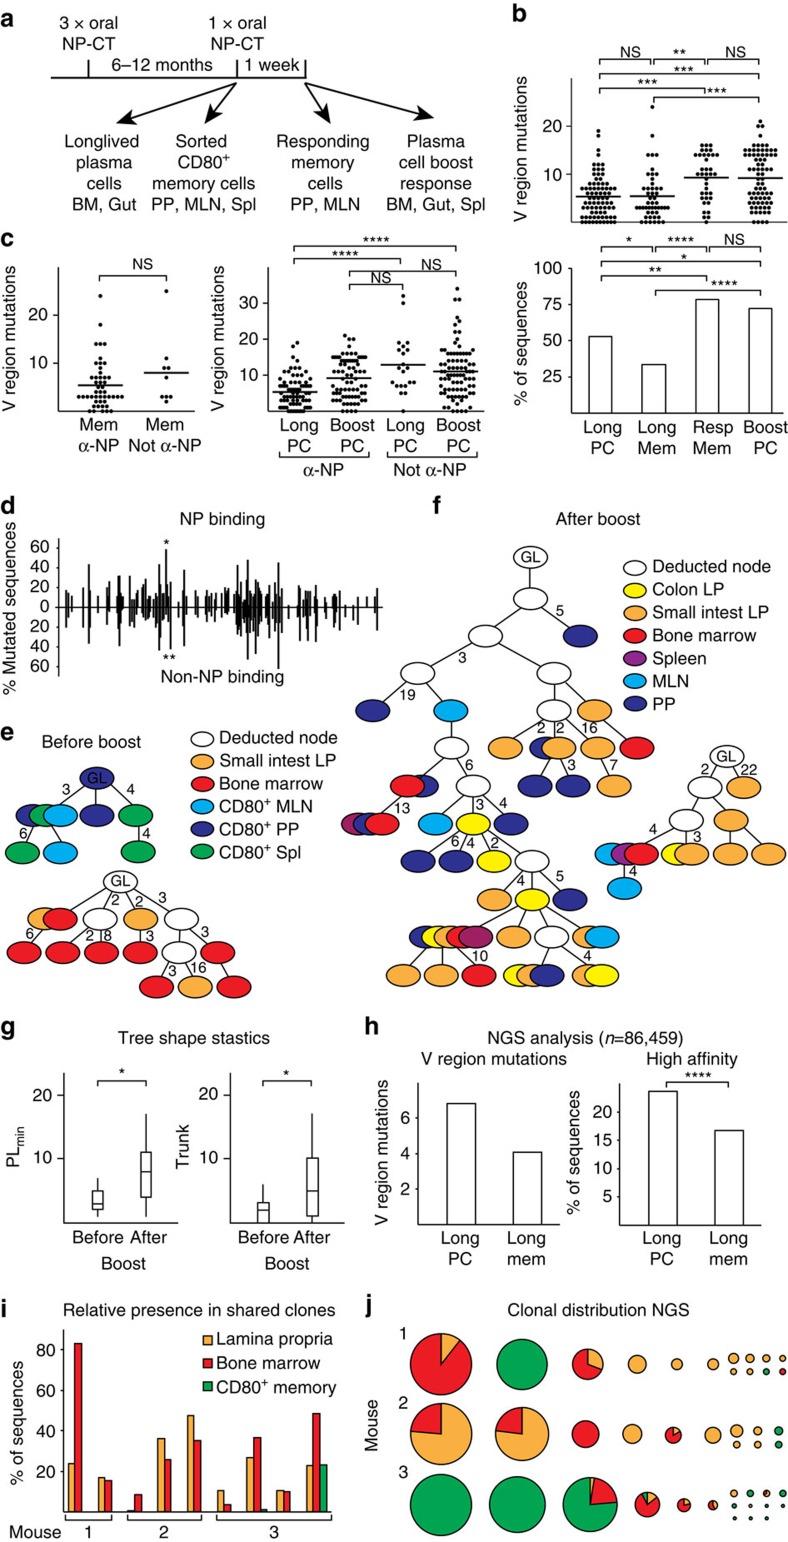
NP-binding IgA VH186.2 gene sequence analysis indicates poor relatedness between gut memory B cells and long-lived plasma cells.(a) Experimental design. Traditional Sanger sequencing analysis of NP-binding IgA VH186.2 genes for mutational load was performed in sorted cells 1 year following three oral priming immunizations. We compared IgA VH186.2 gene sequences in long-lived plasma cells (Long PC) with those of CD80-expressing memory B cells (Long Mem) and IgA VH186.2 gene sequences in responding memory B cells (Resp Mem) with those of SI LP plasma cells (Boost PC) 10 days after boosting (Figs 1d,e and 2e,f; Supplementary Fig. 7a,b). (b) The number of mutations (individual and mean) in the VH186.2 gene region (upper panel) and the proportion of gene sequences with high-affinity mutations (lower panel). (c) The number of mutations in the VH186.2 region of NP-binding sequences was compared with those found in non-NP-binding VH186.2 sequences. Sorted CD80+ memory B cells (left panel) and orally primed IgA plasma cells before (Long) and after booster (Boost) (right panel) are included. P values are given as in b. (d) Distribution of mutations in NP-binding (above the line) and non-NP-binding VH186.2V regions (below the line) are shown. Affinity-enhancing CDR1 mutations at position 98 and the counter-selected mutation in 102 are marked with one or two stars, respectively. (e,f) Examples of clonal trees generated using the IgTree program48 from individual mice before (e; n=3) and after (f; n=6) an oral booster with NP-CT are shown. (g) Tree shape statistics33 were analysed and significant differences were observed in PLmin (minimum tree path length) and trunk length in trees constructed from NP-binding VH186.2 gene sequences from mice before and after a booster immunization. Pooled data from three independent experiments with three to six mice per group. (h) Targeted NGS sequencing of NP-specific IgA VH186 genes expressed in sorted long-lived plasma cells in the SI LP and BM or sorted memory CD80+ B cells from individual mice (n=3). Figures represent mean mutation rates and frequencies of high-affinity mutations analysed in 86,000 NP-binding sequences. For b,c,g and h, the Mann–Whitney test P values are given (not significant (NS) P>0.05, *0.01≤P<0.05, **0.005≤P<0.01, ***0.001≤P<0.005, ****P≤0.001). (i,j) NGS sequences from IgA long-lived plasma cells and CD80+ memory B cells from three individual mice were divided into clones (described in Supplementary Fig. 9). (i) Relative proportion of sequences generated from each mouse that were present in shared clones (for example, two clones from mouse 1 contained sequences from both the LP and BM, and in the first clone 83% of all sequences from the BM and 24% from the LP were present). (j) The distribution of sequences between clones (clones with only one sequence excluded). The actual number of sequences allocated to a clone is indicated by the size of the pie chart, and the distribution of origin of the sequences within the pie chart with colours.